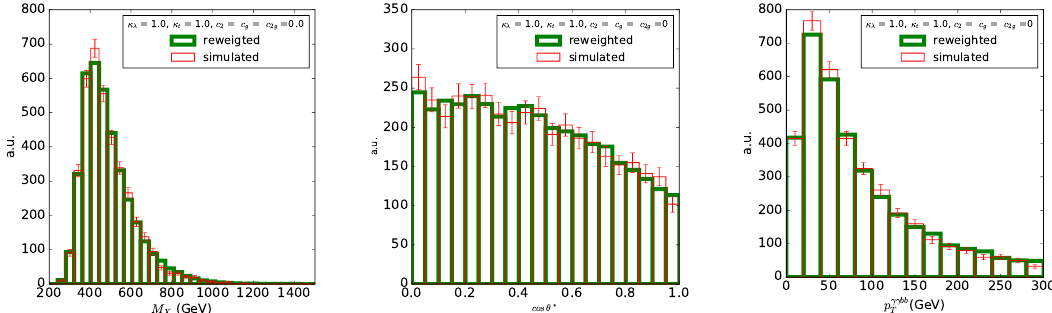
Figure 2 . Reconstructed variables after ATLAS-like selection for the di-Higgs system. The his- tograms display the signal efficiency times 100,000 events.